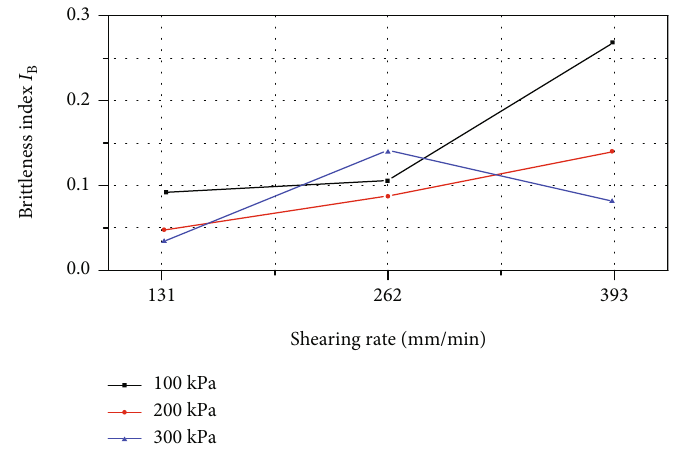
Figure 7: Brittleness index versus shearing